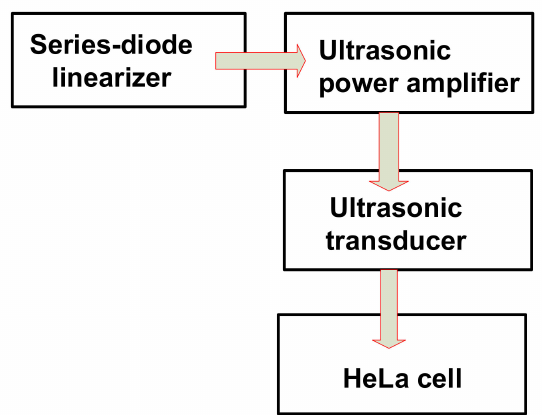
Figure 1. Strategic representation of an ultrasonic power amplifier integrated with a series-diode linearizer.